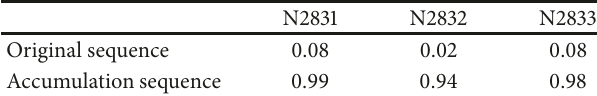
Table 1: The Hurst exponent value of three groups of